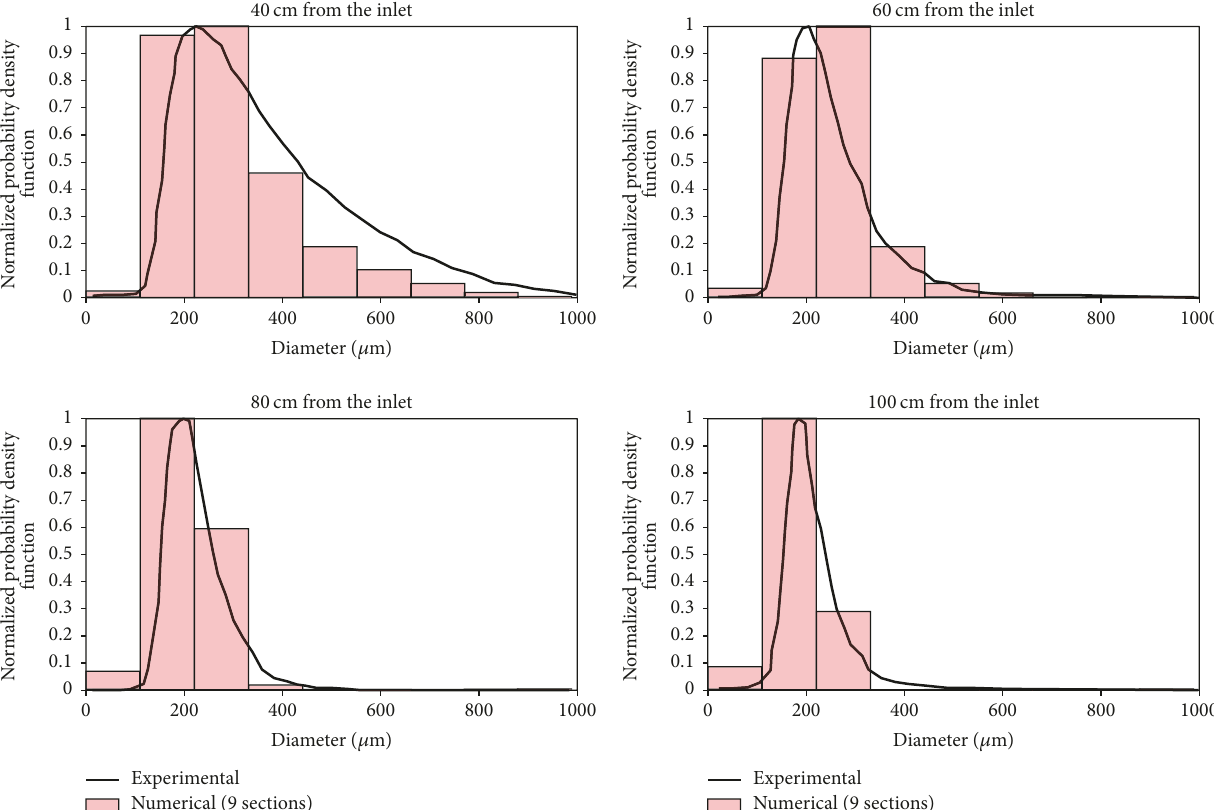
Figure 40: Comparison between experimental and numerical size distributions on the symmetrical axis and for different distances from the inlet.